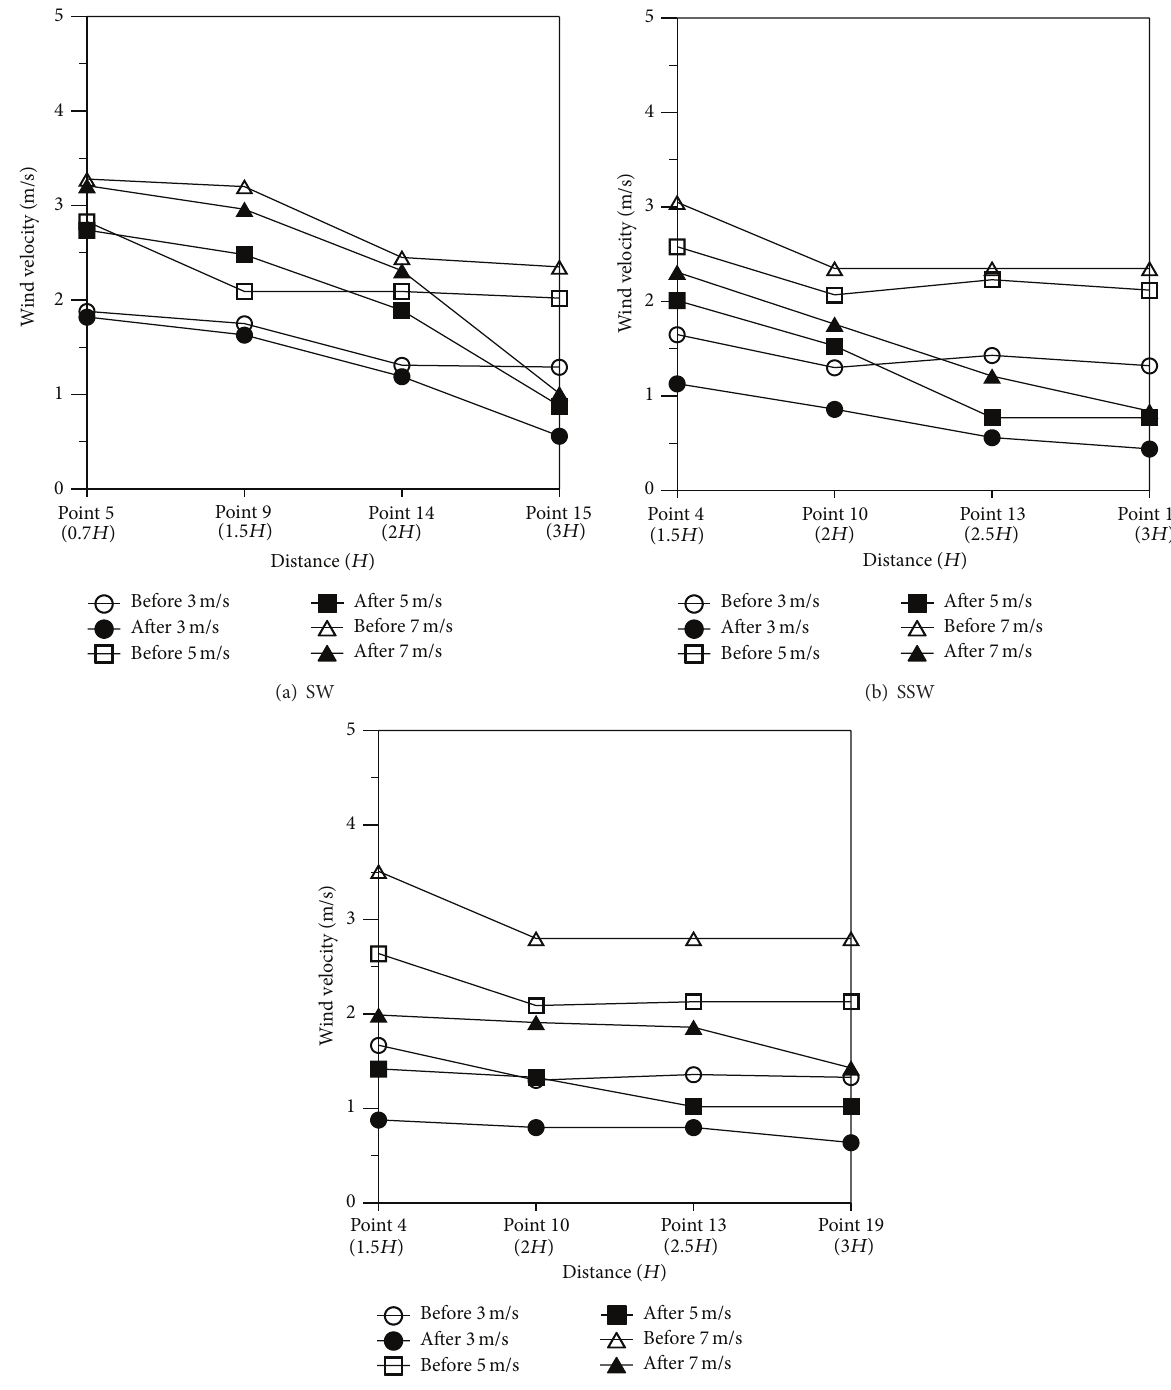
Figure 7: Wind velocities per minute by embankment’s distance according to wind angle changes.